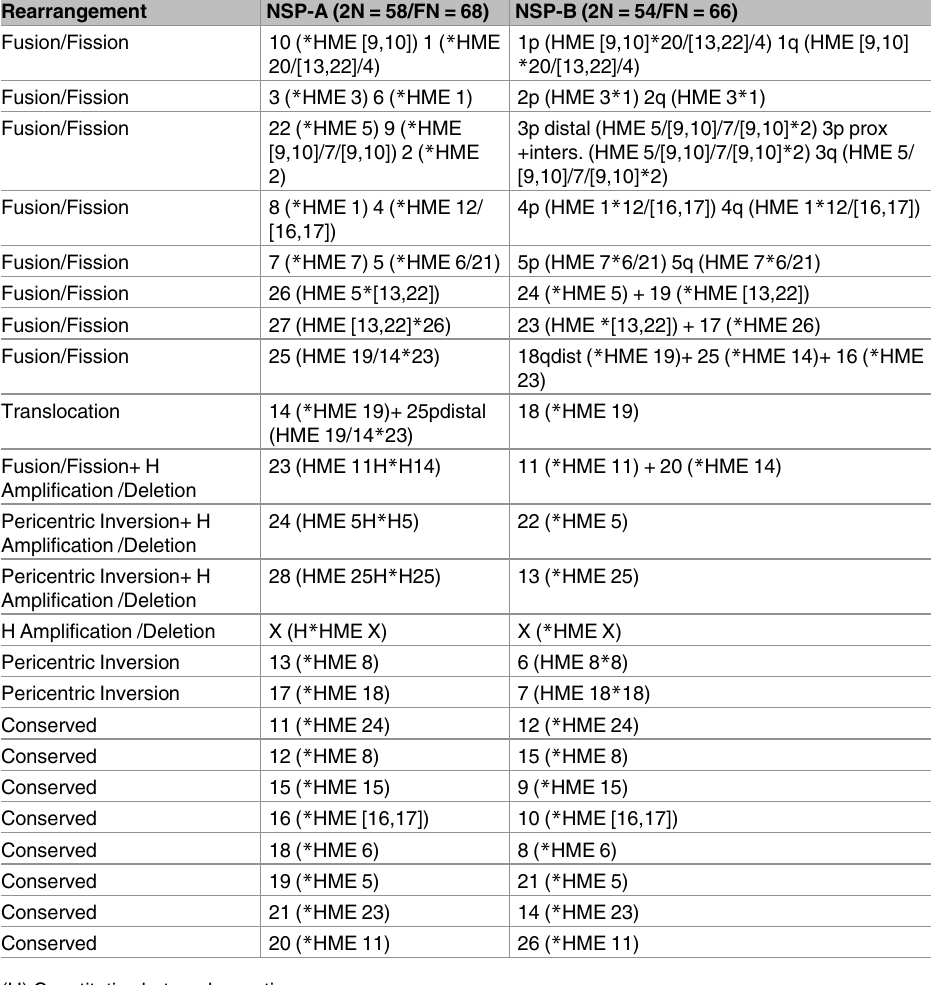
Table 4. NSP-A and NSP-B rearrangements involved.